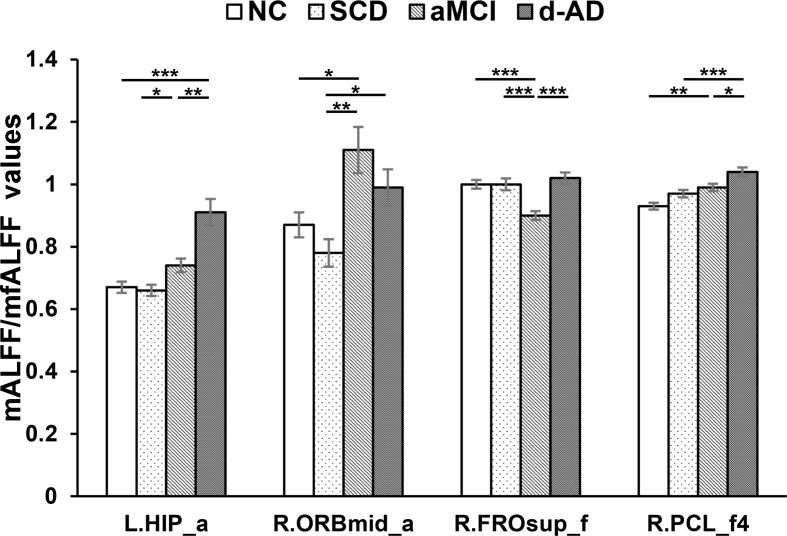
Increased ALFF and fALFF patterns tendency in patient groups. ∗ represents significant level P < 0.05, ∗∗ means significant level P < 0.01, and ∗∗∗ means significant level P < 0.001. L., left; R., right; L.HIP, Hippocampus_L (aal); R.ORBmid, Frontal_Mid_Orb_R (aal); R.FROsup, Frontal_Sup_R (aal); R.PCL, Paracentral_Lobule_R. a, ALFF analysis in full band (0.01–0.1 Hz); a4, ALFF analysis in slow-4 band (0.027–0.073 Hz); a5, ALFF analysis in slow-5 band (0.01–0.027 Hz); f, fALFF analysis in full band; f4, fALFF analysis in slow-4 band; f5, fALFF analysis in slow-5 band.